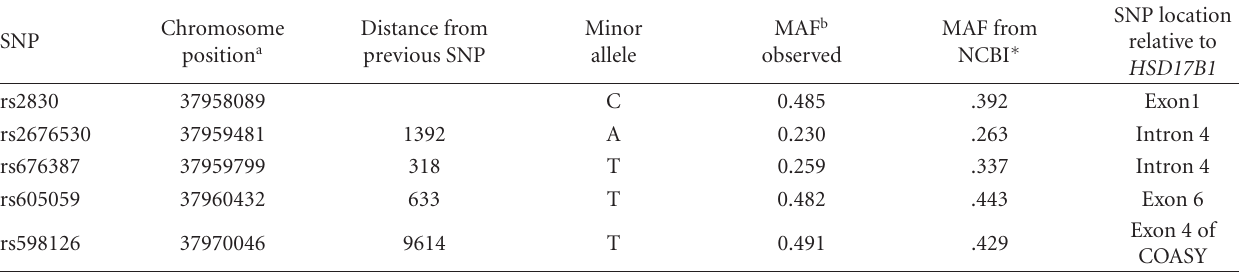
Table 2: HSD17B1 SNP chromosomal location a .